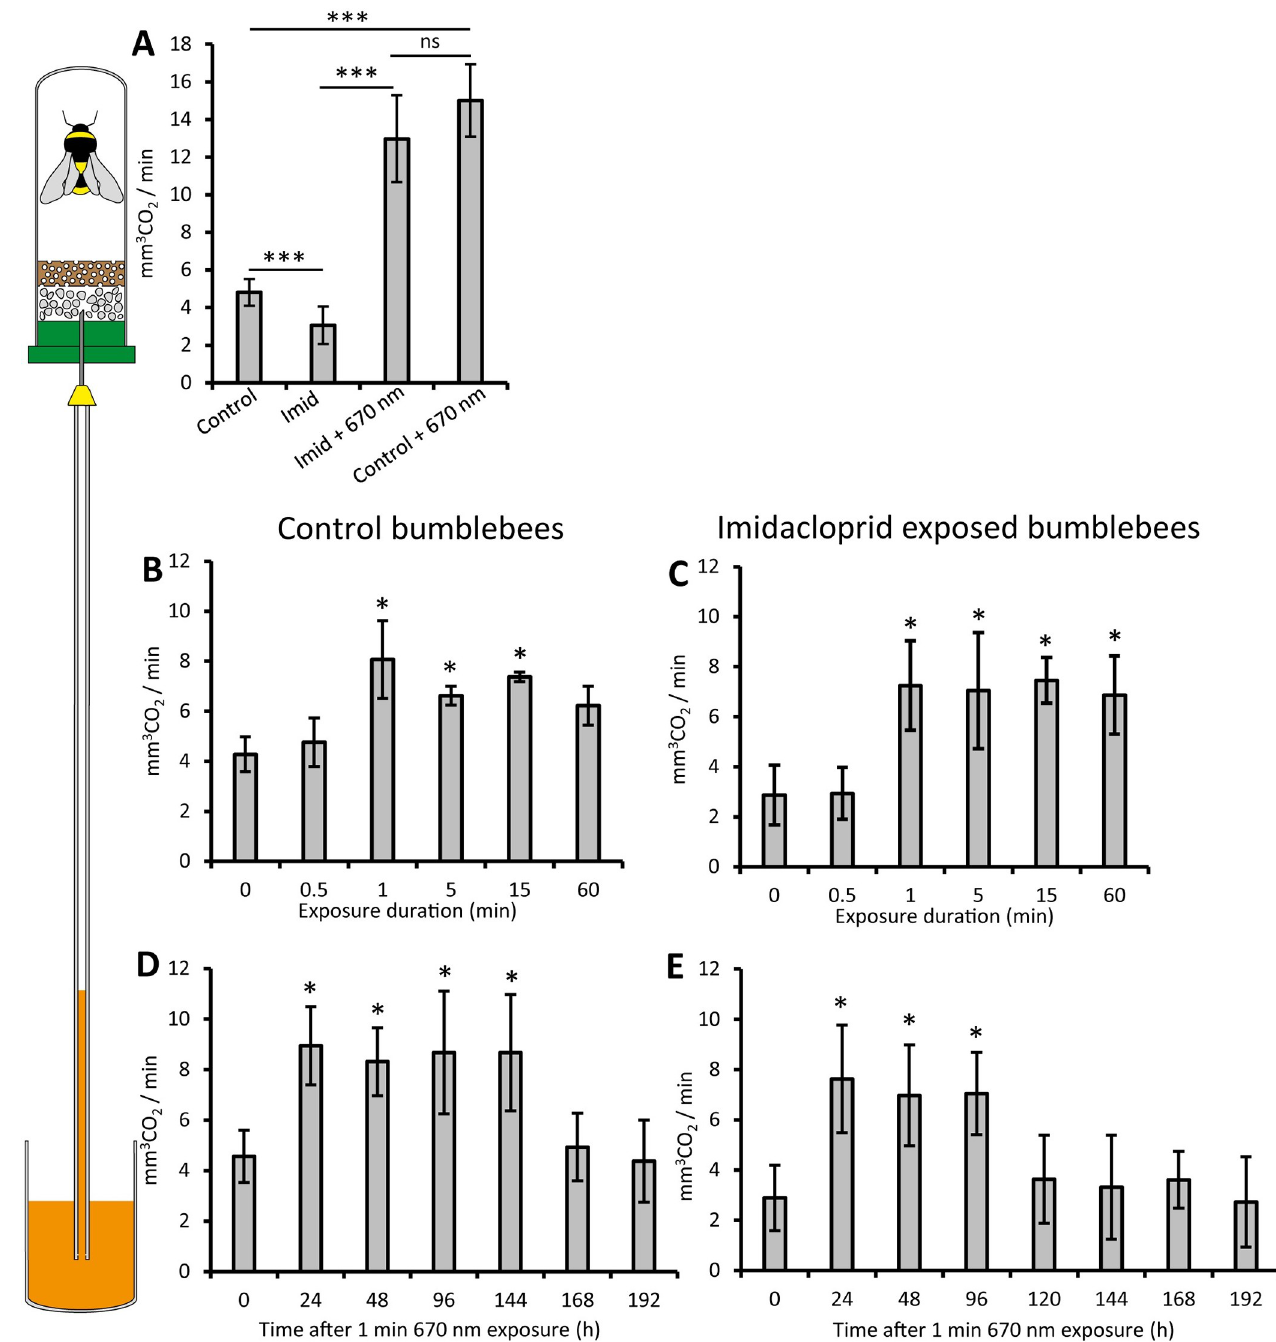
Fig 1. Effects on respiration. Individual bumblebee respiration was measured as shown in the schematic to the left. Bumblebees were subjected to 5 day exposure to Imidacloprid and/or 670nm ( � 18 bees per group). A. Imidacloprid had a significant impact reducing respiration, but this was corrected by exposure to 670nm light. The amount of light required, and the duration of this effect were then determined. B. Bumblebees ( � 20 bees per group) were exposed to 670nm light for 0.5, 1, 5, 15 or 60mins and respiration measured. Controls (0) were not exposed. Exposure for 0.5 min had no impact. However, 1 min light exposure significantly increased respiration. Longer exposures were similar. The same metric was determined in Imidacloprid exposed bumblebees, again 0.5min exposure had no impact, however durations between 1 and 60mins induced significant increase in respiration (C). Bumblebees ( � 18 bees per group) were exposed to a single 670nm for 1 min (D) and respiration measured at 24h intervals. This elevated respiration for 144h but then declined rapidly. A single 1min exposure of 670nm in Imidacloprid treated bees also elevated respiration, for 96h (E), a slight reduction in duration compared to the effect of 670nm on non-pesticide exposed bees (D). Abbreviations: � ; p < 0.05, ��� ; p < 0.005, ns; no significance. Imid; Imidacloprid.